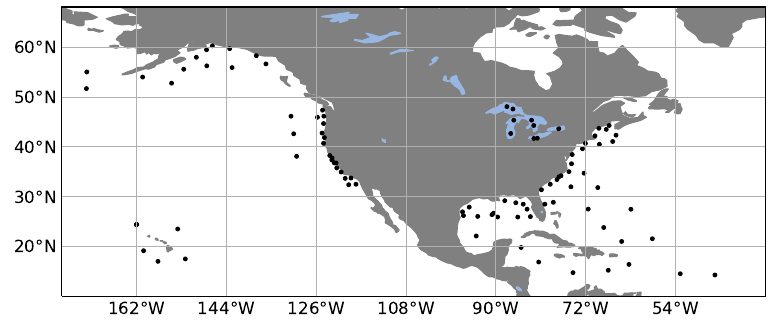
Figure 2. NDBC buoy data used in the